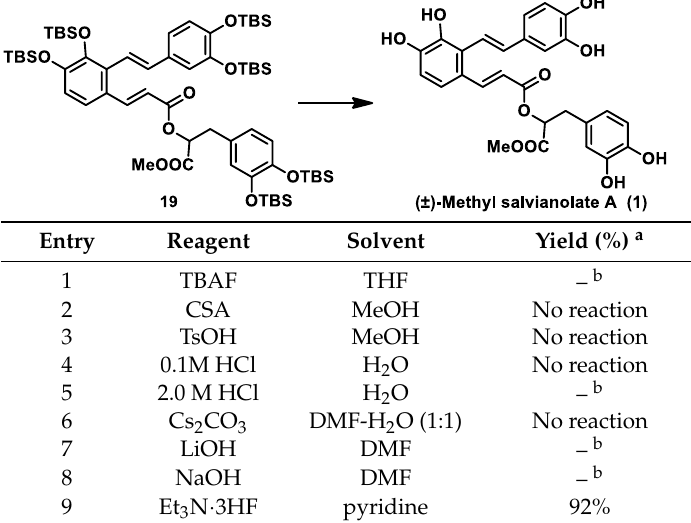
Table 1. Completion of the total synthesis of (±)-methyl salvianolate A.